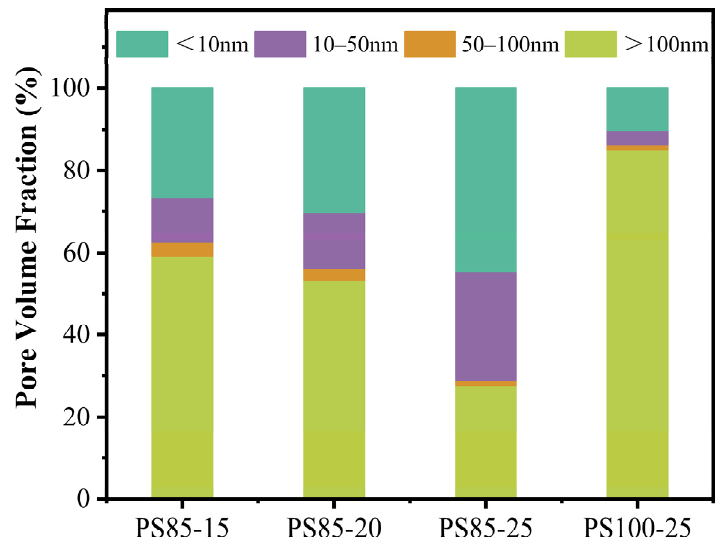
Figure 11. Pore volume fraction of WUFA-PS and PS-based geopolymers at 28 days.